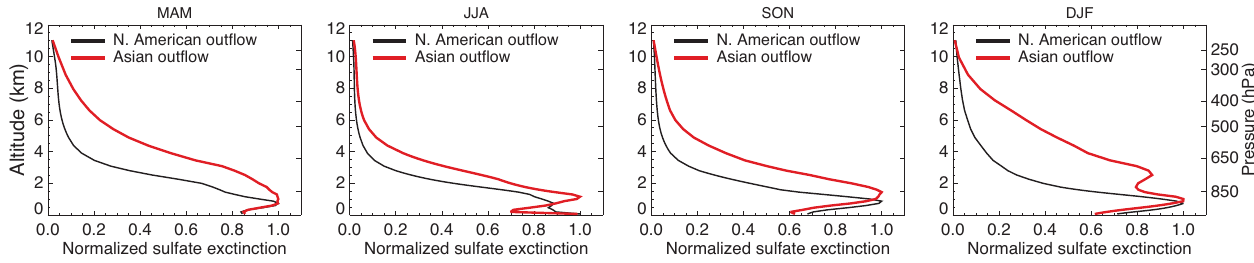
Fig. 11. Seasonal composite of GEOS-Chem sulfate extinction profiles on LRT + days in the outflow regions of N. America (30–50 ◦ N, 60 ◦ W, black line) and E. Asia (30–60 ◦ N, 150 ◦ E, red line). The sulfate extinction profiles are normalized by the maximum extinction values for each season. From left to right: MAM, JJA, SON,